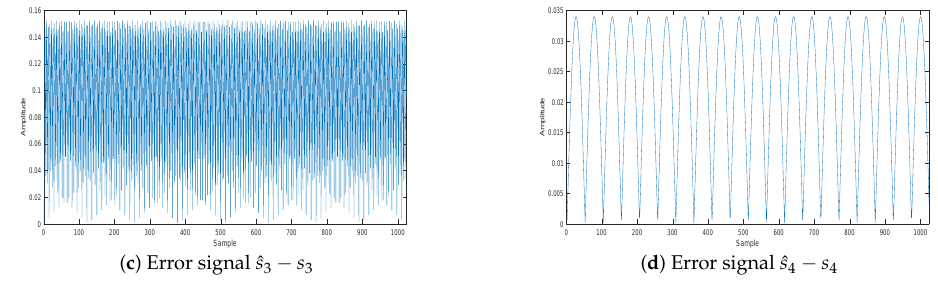
Figure 16. Separation signal error analysis.